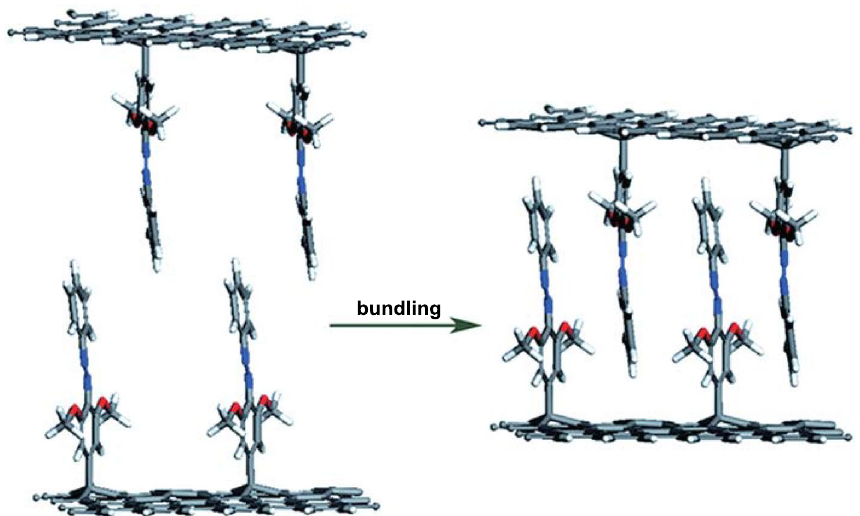
Fig. 8 Illustration of the mechanism of inter-planar bundling for high functionalization density Azo–RGO hybrids, which show no packing interaction in the solution (left) because of a large interlayer spacing but show packing interaction in the solid state forms because of the bun- dling with a low interlayer space (right)